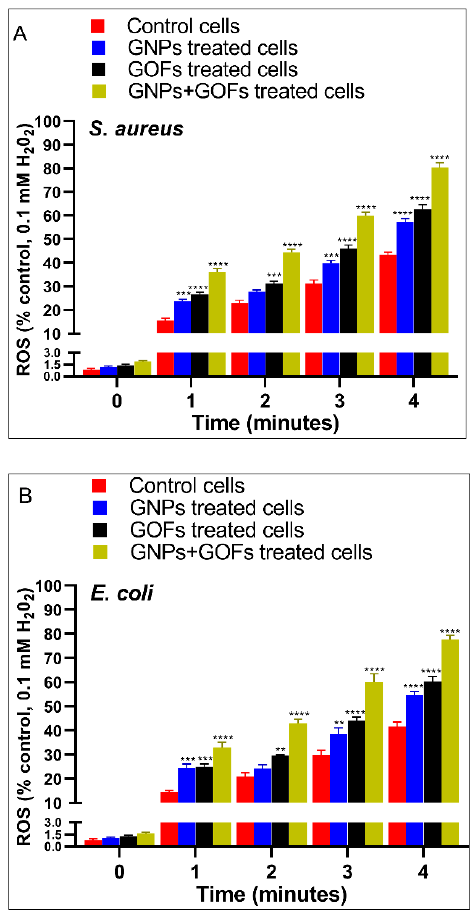
Figure 7. GNPs and GOFs increase reactive oxygen species (ROS) responses to bacterial strains in BMDMs. BMDMs were pre-treated with GNPs, and GOFs were then infected with Staphylococcus aureus or Escherichia coli . ROS was measured using Ampliflu. Kinetic readings of representative data are shown as mean ± SE at the indicated time. Statistical significance by two-way ANOVA ( p < 0.0001) followed by posthoc testing using Tukey’s multi group comparison with control cells: *** p = 0.001, **** p < 0.0001 indicate statistically different for ( A ) S. aureus while ** p = 0.002, *** p = 0.0003, **** p < 0.0001 indicate statistically different for ( B ) E. coli